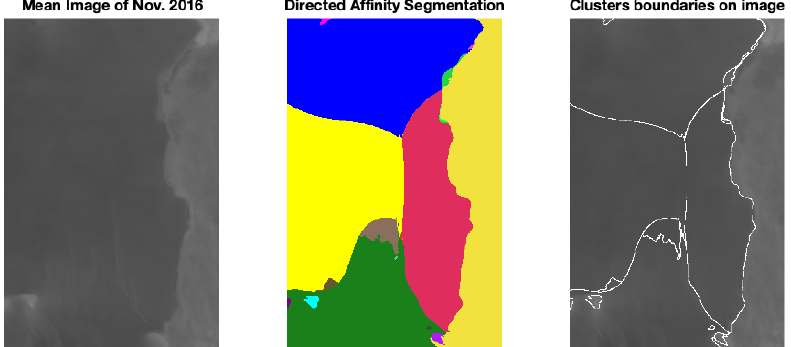
Figure B6. The mean image and the directed affinity partitioning as of November 2016. Raw images sourced from Scambos et al.